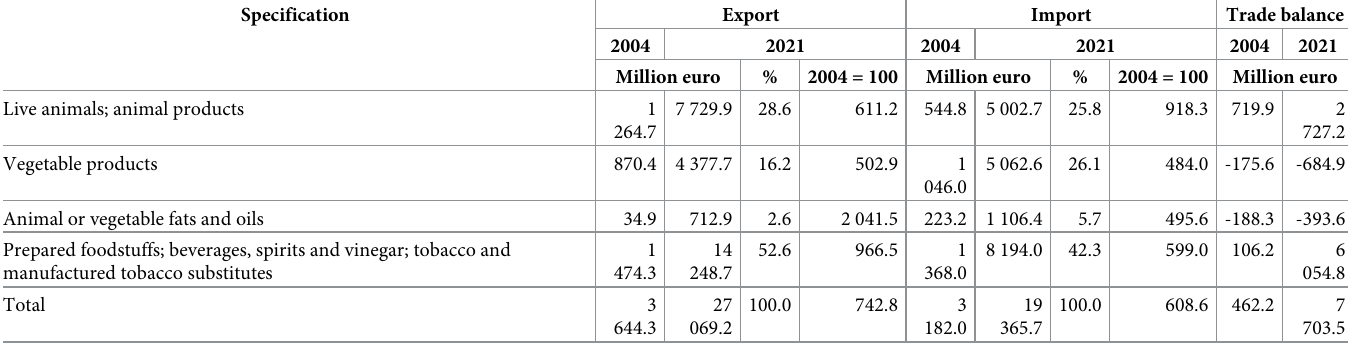
Table 2. Commodity structure of Poland’s foreign trade in agri-food products with the other EU countries in 2004 and 2021.